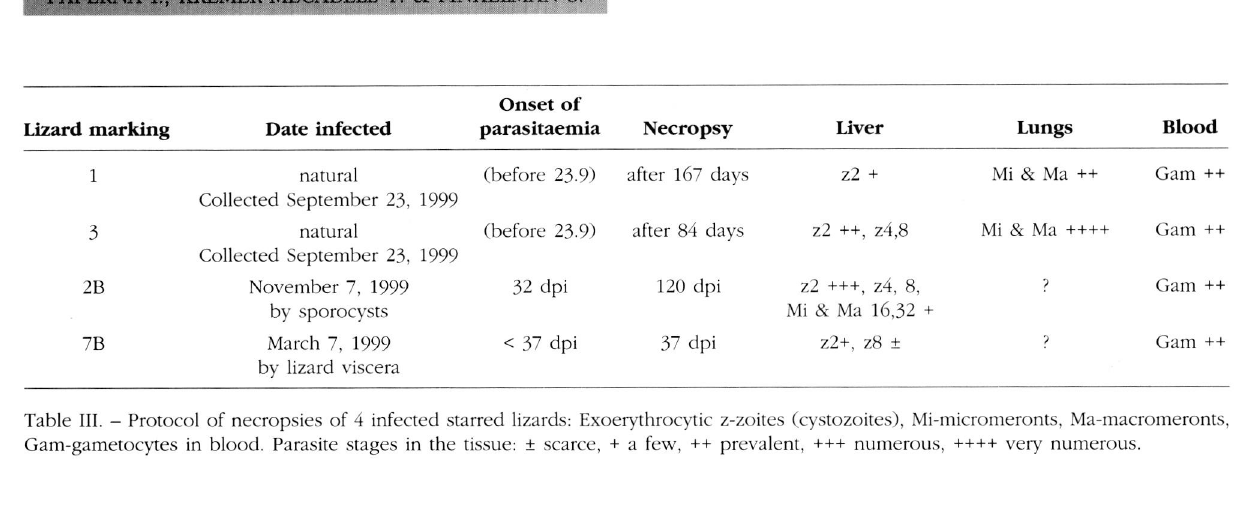
Table III. - Protocol of necropsies of 4 infected starred lizards: Exoerythrocytic z-zoites (cystozoites), Mi-micromeronts, Ma-macromeronts, Gam-gametocytes in blood. Parasite stages in the tissue: ± scarce, + a few, ++ prevalent, +++ numerous, ++++ veiy numerous.